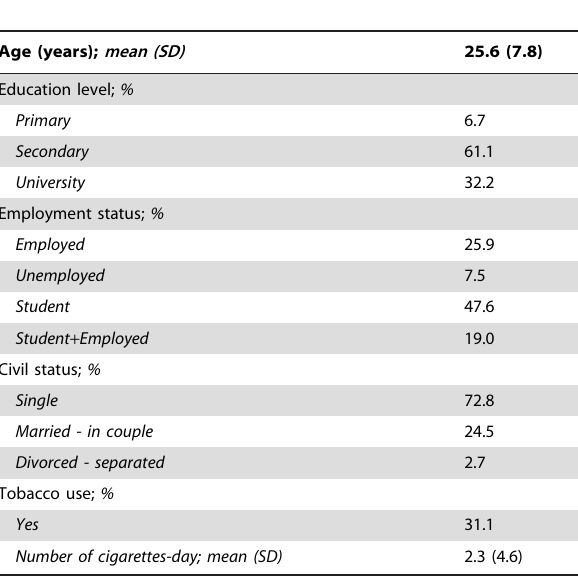
Table 1. Sociodemographic